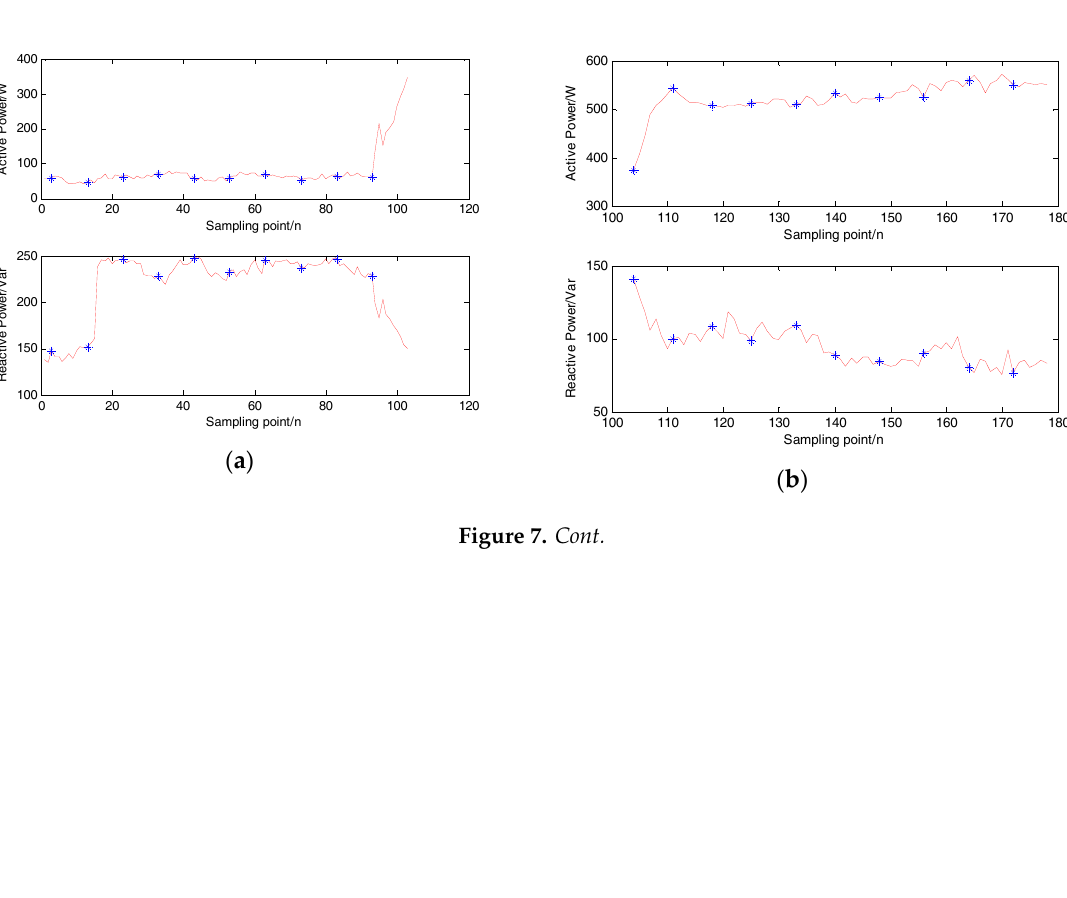
Table 4. Differences on the load switching point.